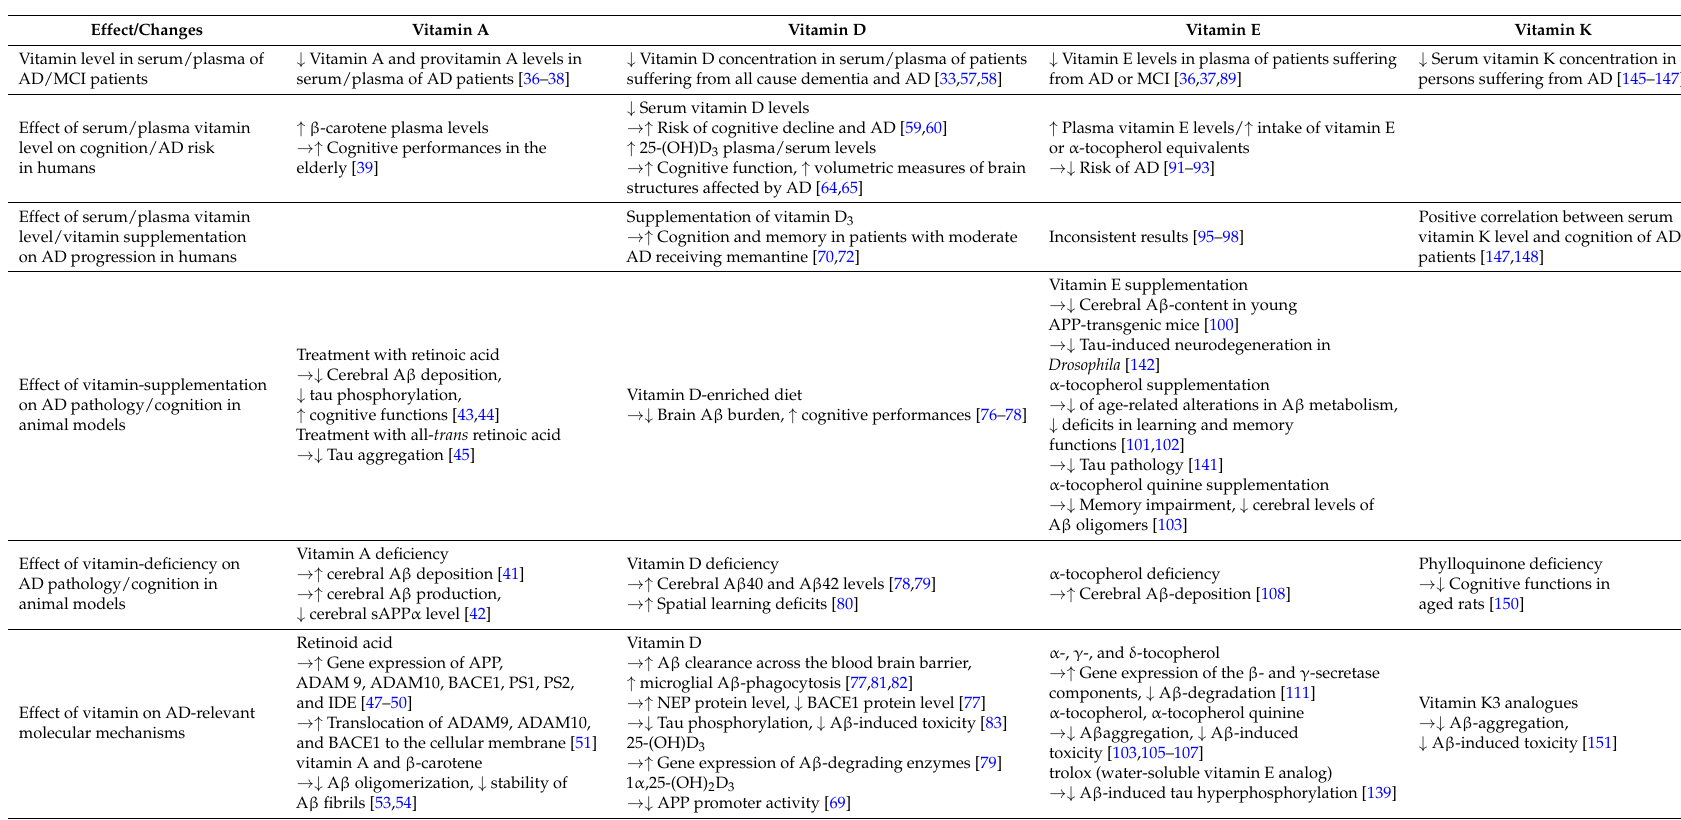
Table 1. Summary of the impact of vitamins A, D, E, and K on Alzheimer’s disease (AD) risk, cognitive functions, and the molecular mechanisms of AD. The presented data are derived from in vitro experiments using, e.g., cell culture models, in vivo models, such as transgenic animals, and the analysis of AD patients, but not from clinical experiments. MCI, mild cognitive impairment; APP, amyloid precursor protein; ADAM 9, a disintegrin and metalloprotease 9; ADAM10, a disintegrin and metalloprotease 10; BACE1, β -site APP cleaving enzyme 1; PS1, presenilin 1; PS2, presenilin 2; IDE, insulin degrading enzyme; → , effect; ↑ , increase; ↓ , decrease. Vitamin A Vitamin D Vitamin E Vitamin